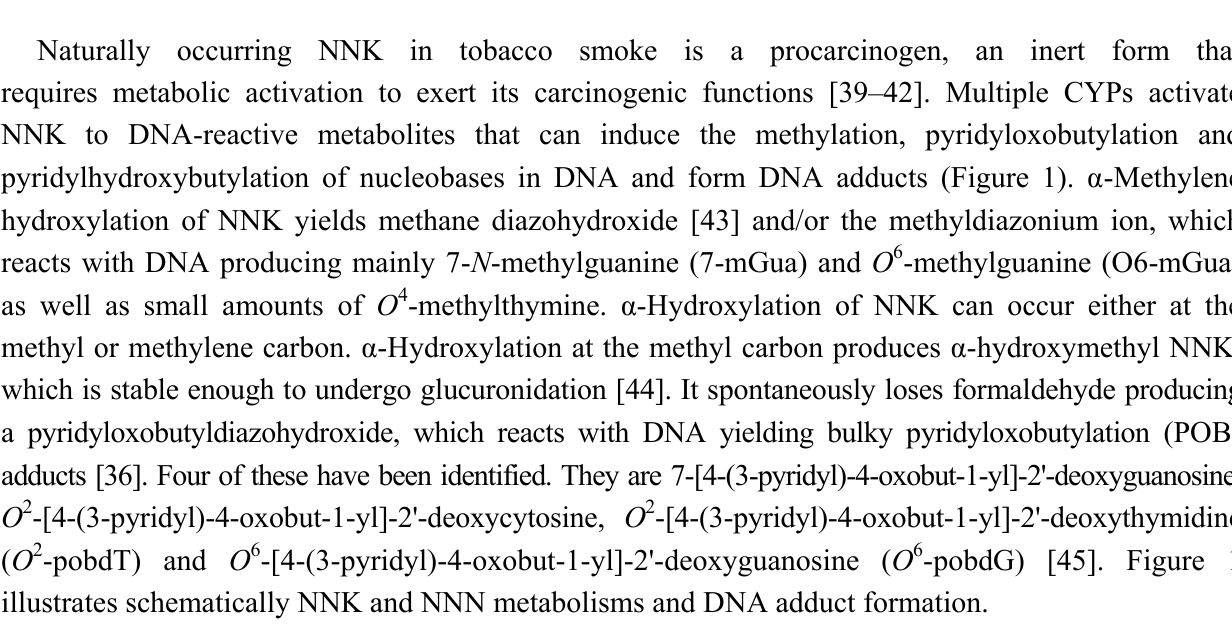
Figure 1. Schematic illustration of the pathways of NNK and NNN metabolism and DNA adduct formation as determined by studies in laboratory animals and